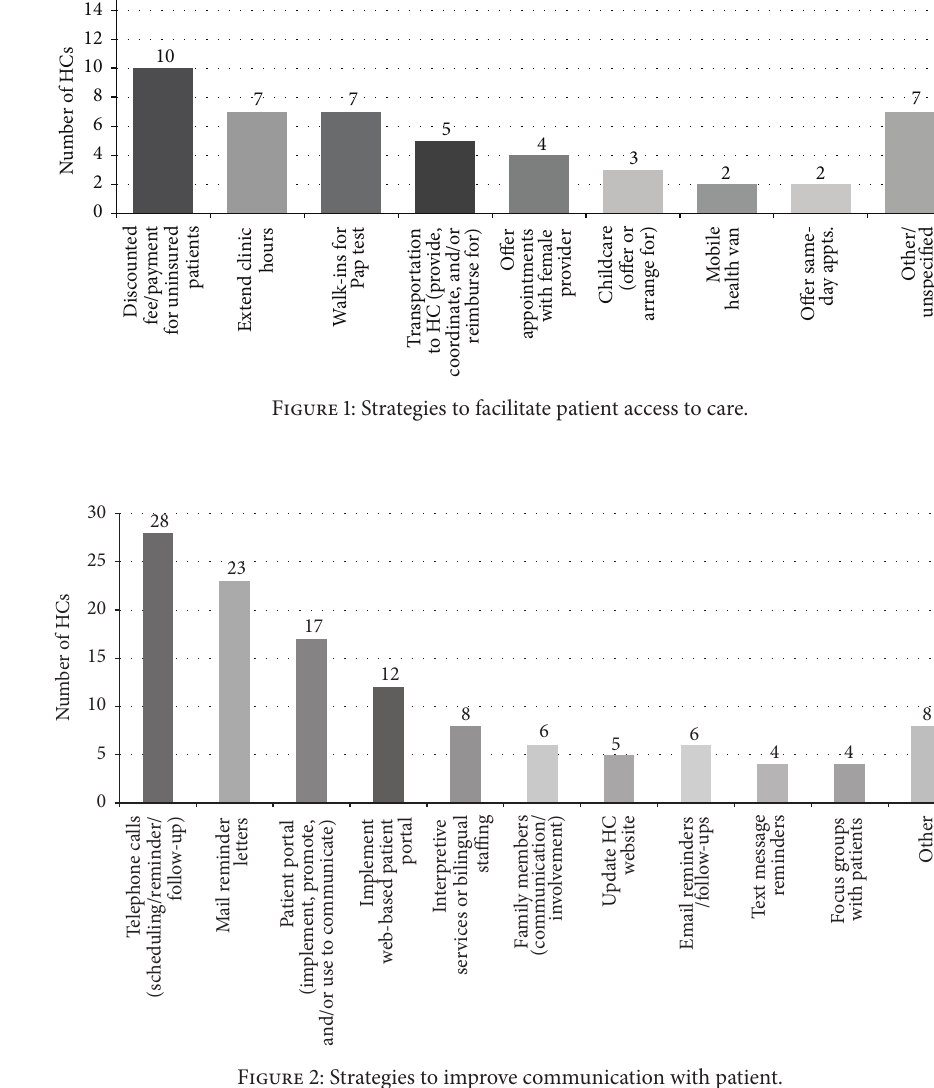
Figure 2: Strategies to improve communication with